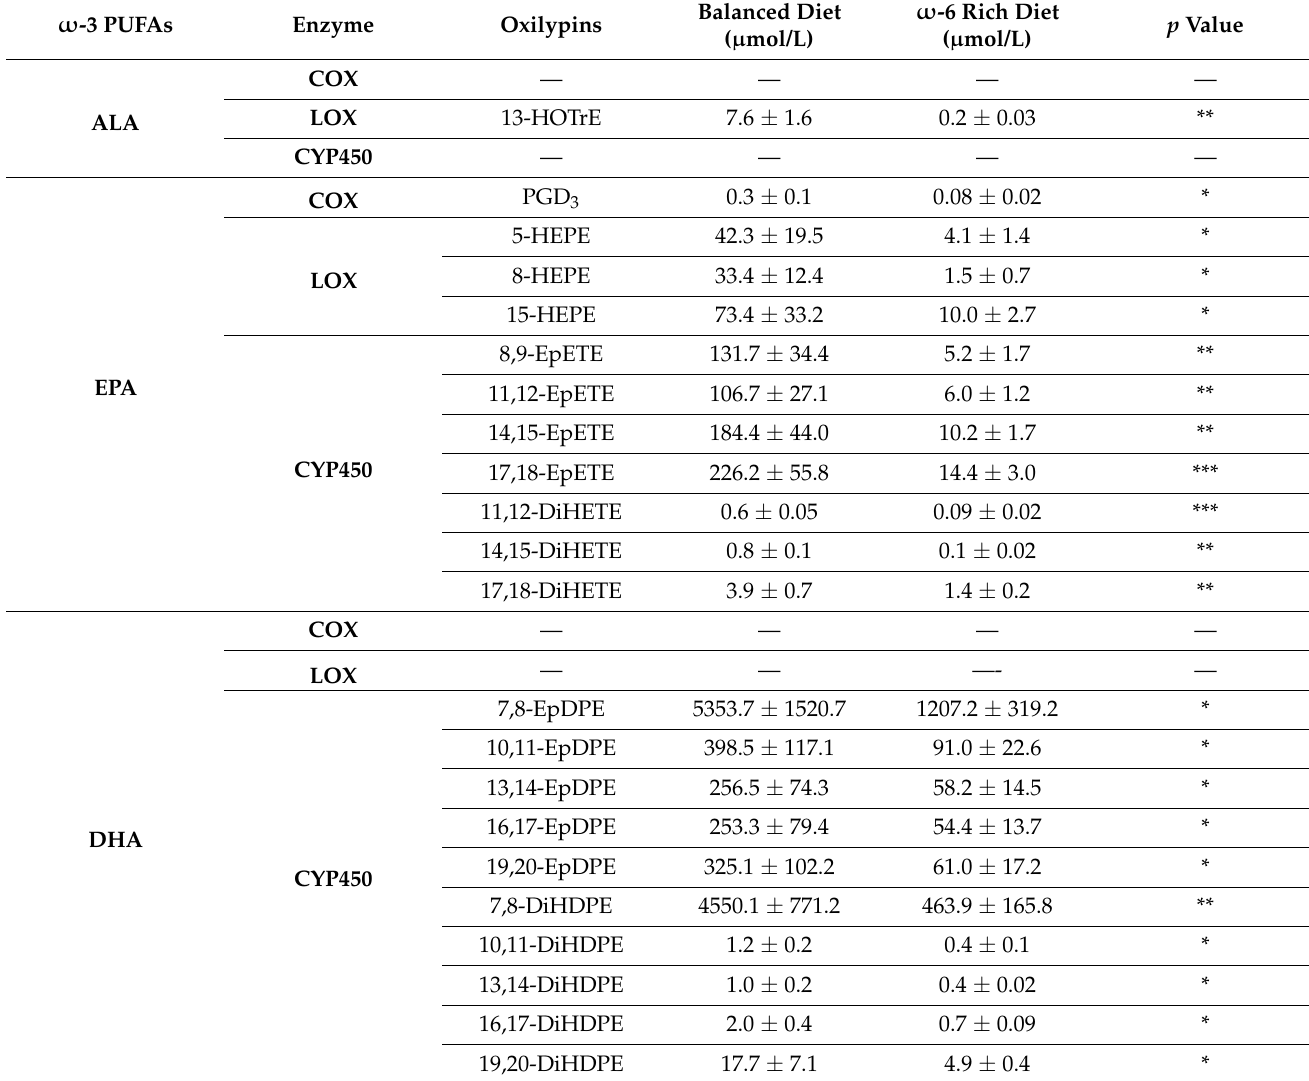
Table 2. ω -3 oxylipins levels in plasma of mice with balanced and ω -6 rich diet. ω -3